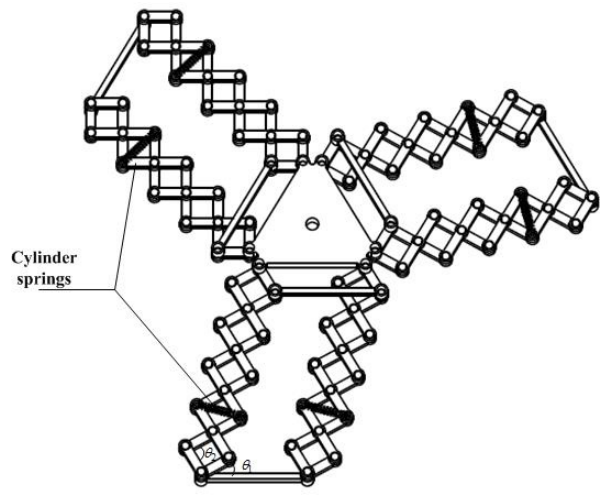
Figure 17. Cylinder springs connecting the horizontal joints.